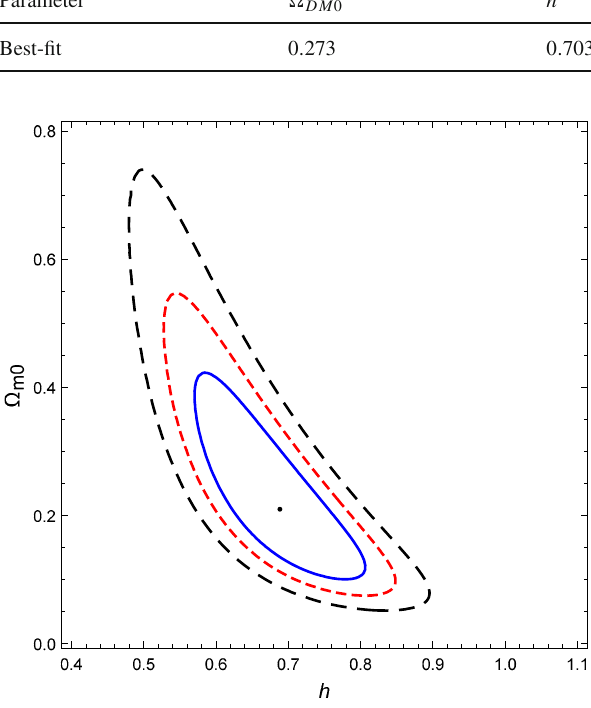
Fig. 6 Contour plot in (cid:11) DM 0 - h Plane